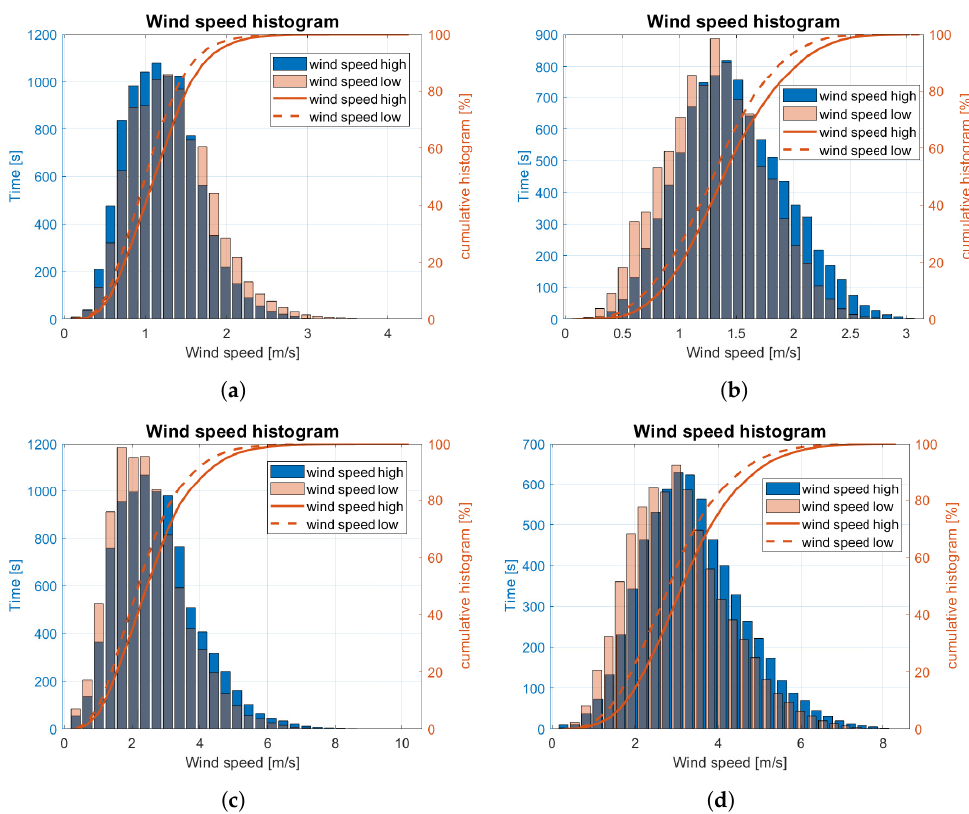
Figure 16. Normalized wind speed histograms for 2.5 h experiment: ( a ) week wind; ( b ) medium week wind; ( c ) medium strong wind; ( d ) strong